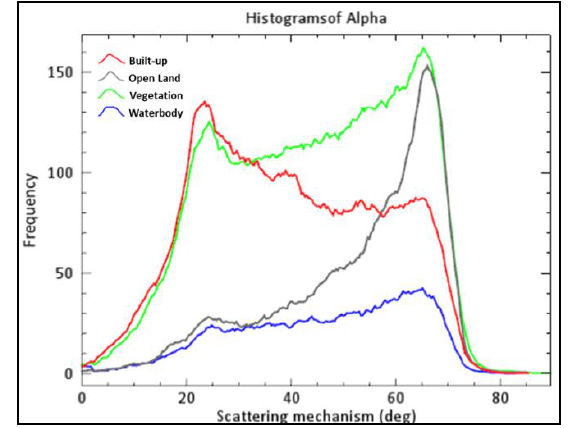
Figure 5: Histogram of Alpha in different Land cover